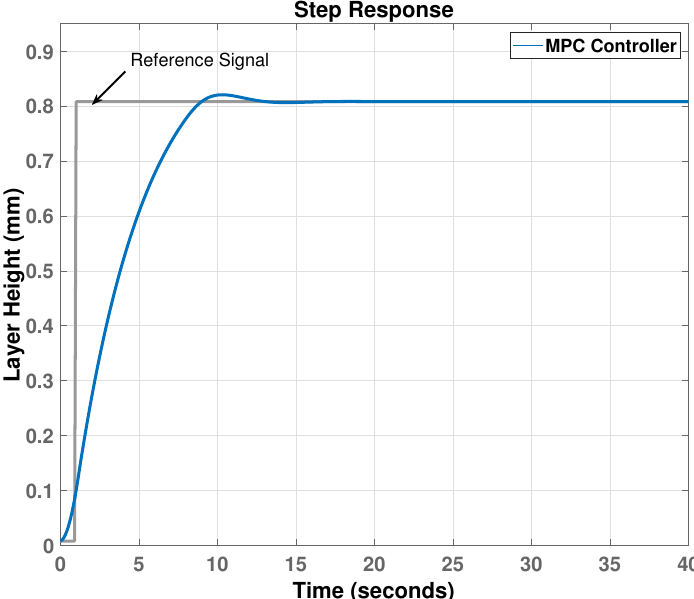
Figure 11. Step response of the closed-loop feedback system.